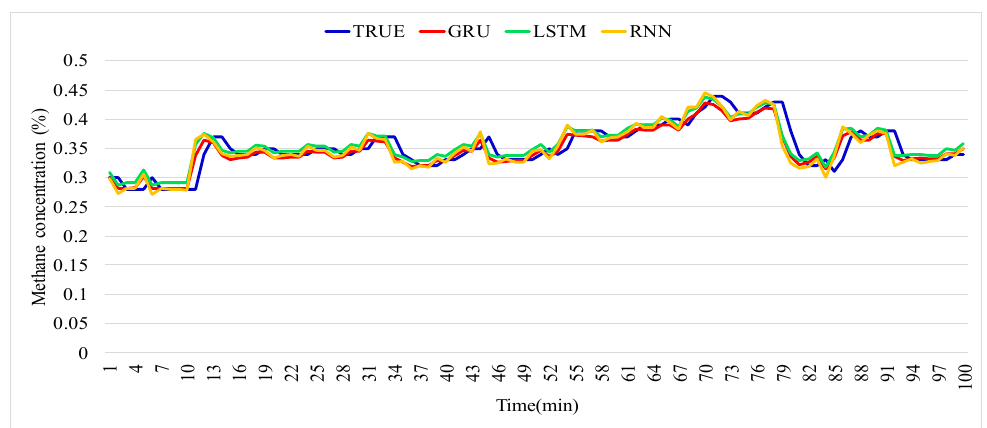
Figure 7. Comparison between methane concentration predictions obtained using three RNN-based models.